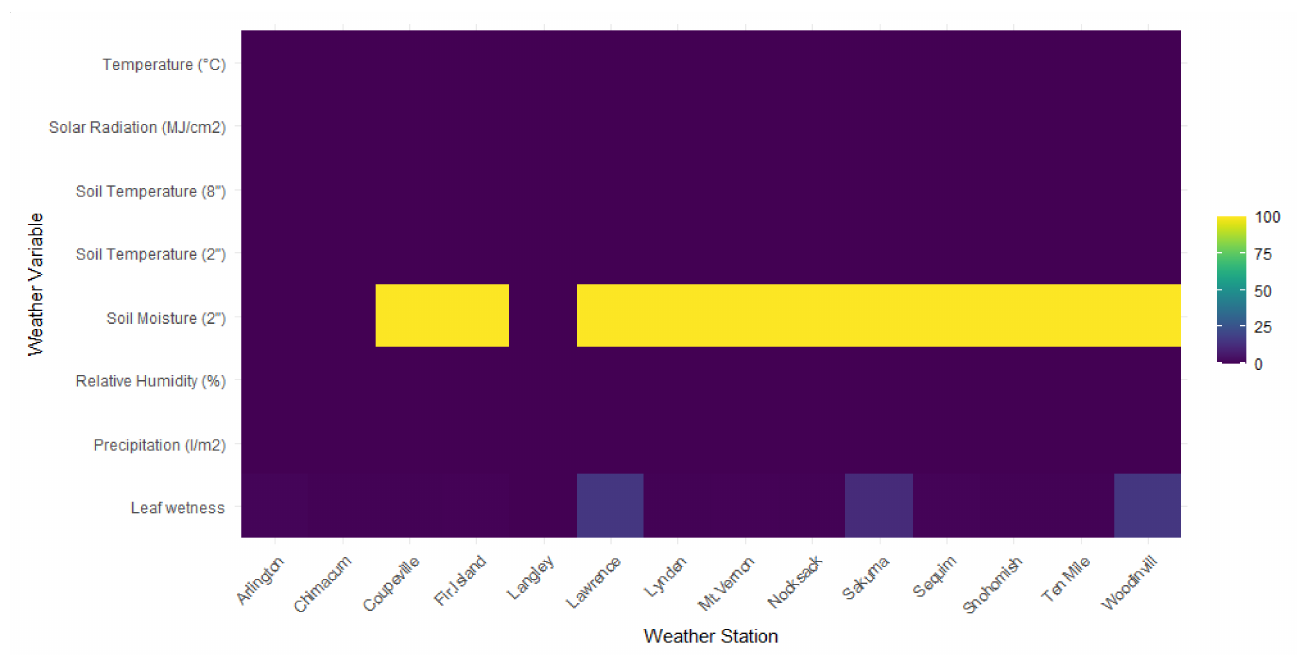
Figure 2. An overview of the available weather variables per weather station location with percentage of missing data (%). Data were obtained from Washington State University’s AgWeatherNet for the period